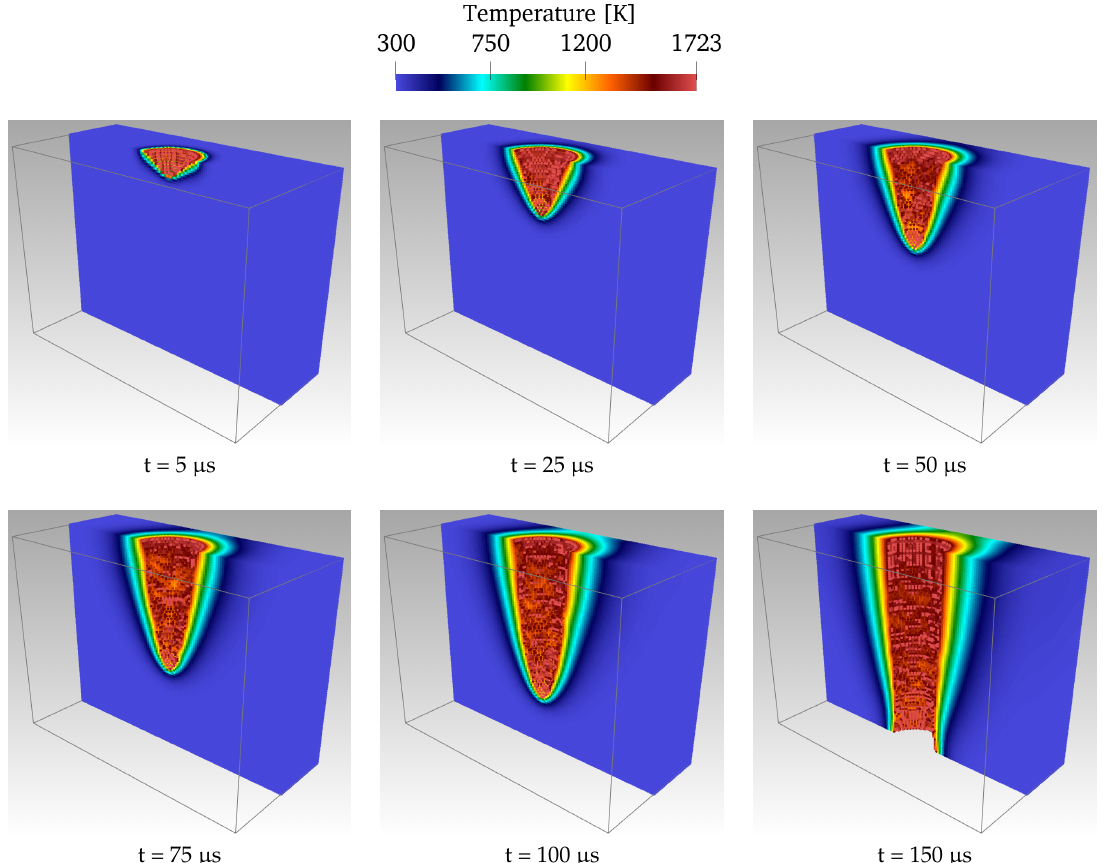
Figure 11. Formation of the popped hole due to heat transfer in a simplified laser drilling process. Snapshots of the temperature distribution were taken from a thermal simulation using PSE at a high resolution. The whole workpiece is discretized with approximately 672k particles, but only one half is shown for better